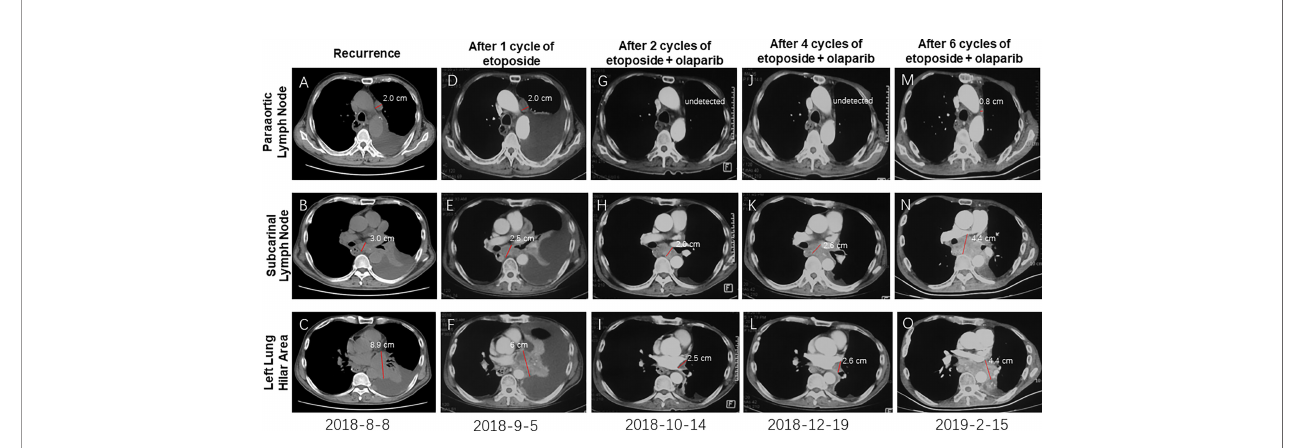
FIGURE 2 | CT imaging showing the recurrent masses and the change of these masses after therapy. Masses after recurrence (A – C) ; The recurrent masses kept stable after 1 cycle of etoposide (D – F) ; The recurrent masses were obviously shrunk after 2 cycles of etoposide-olaparib (G – I) ; These masses kept stable after 4 cycles (J – L) and 6 cycles (M – O) of